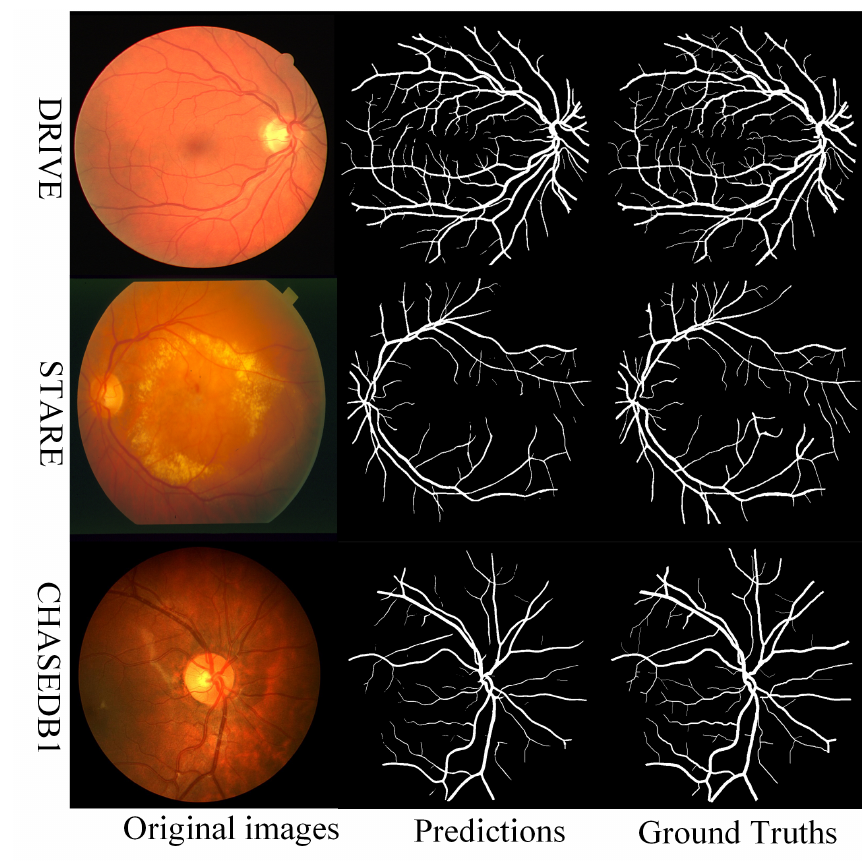
Figure 2. Example segmentation results on three